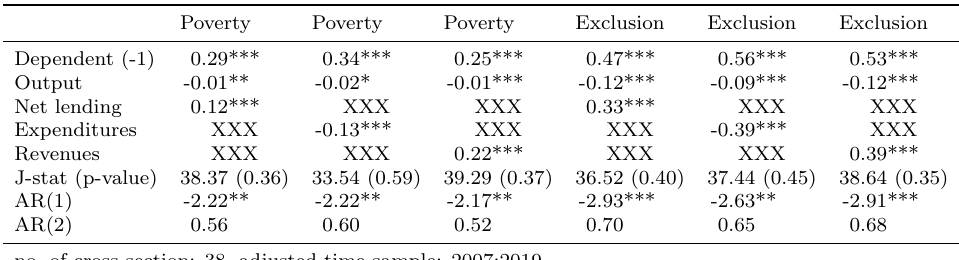
Table 4: Underperforming